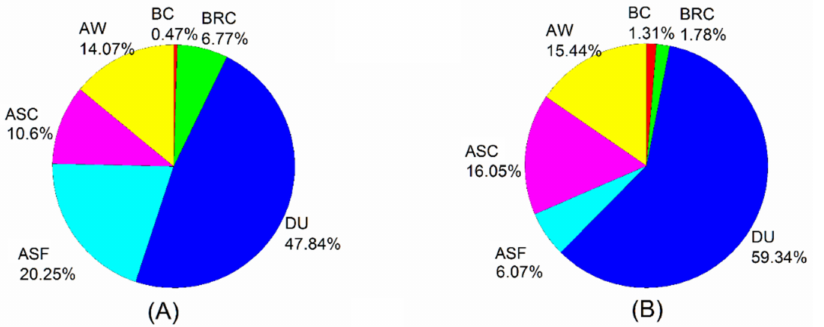
Figure 10. Monthly mean mass fractions of aerosol components for typical regions in January 2012 as retrieved from POLDER/PARASOL satellite observations in BJ ( A ) and SX ( B ) region (as Figure